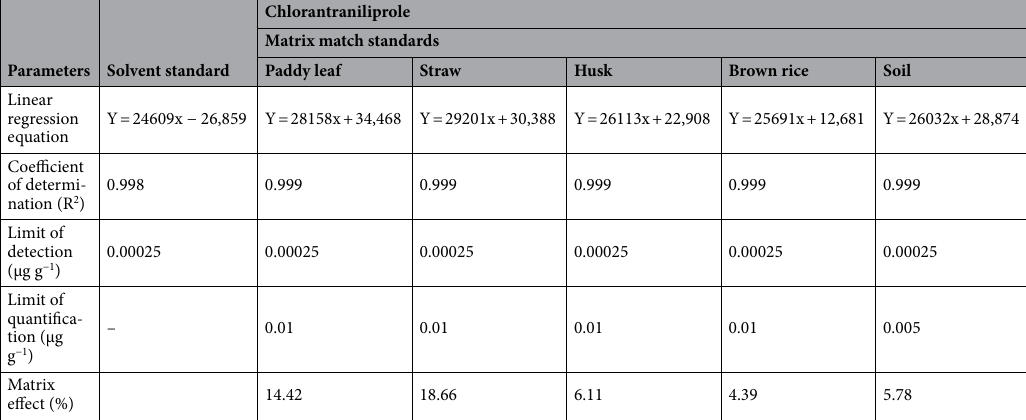
Table 2. The linear regression, coefficient of determination (R 2 ) and matrix effect for chlorantraniliprole in paddy leaf and